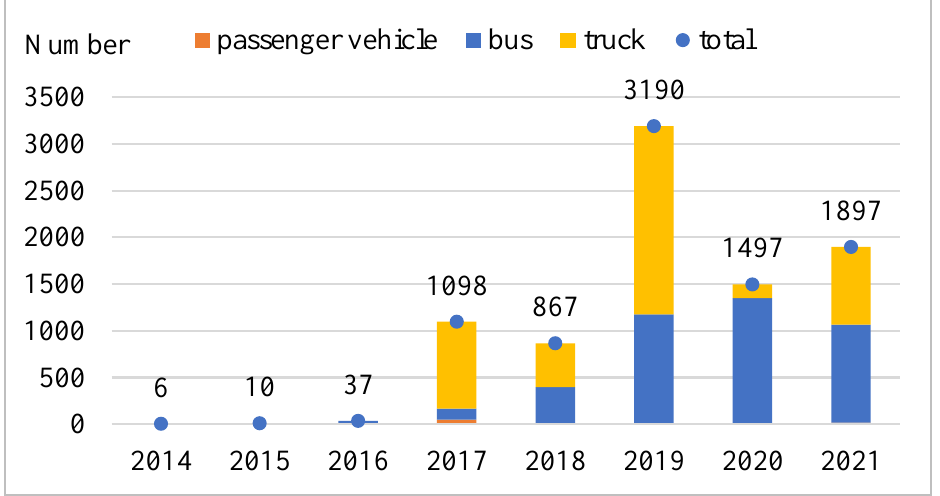
Figure 2. Annual number of insured fuel cell vehicles in China.